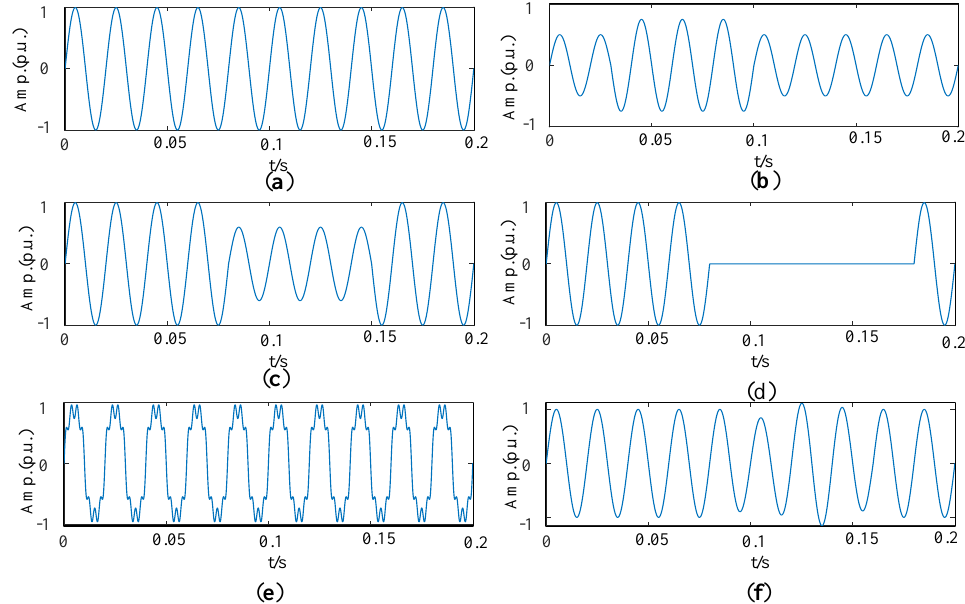
Figure 3. Power quality measured signal: ( a ) normal signal; ( b ) swell; ( c ) sag; ( d ) interruption; ( e ) harmonics; ( f ) flicker. Table 3. Algorithm running time comparison. SNR, signal-to-noise ratio; PNN, probabilistic neural networks.